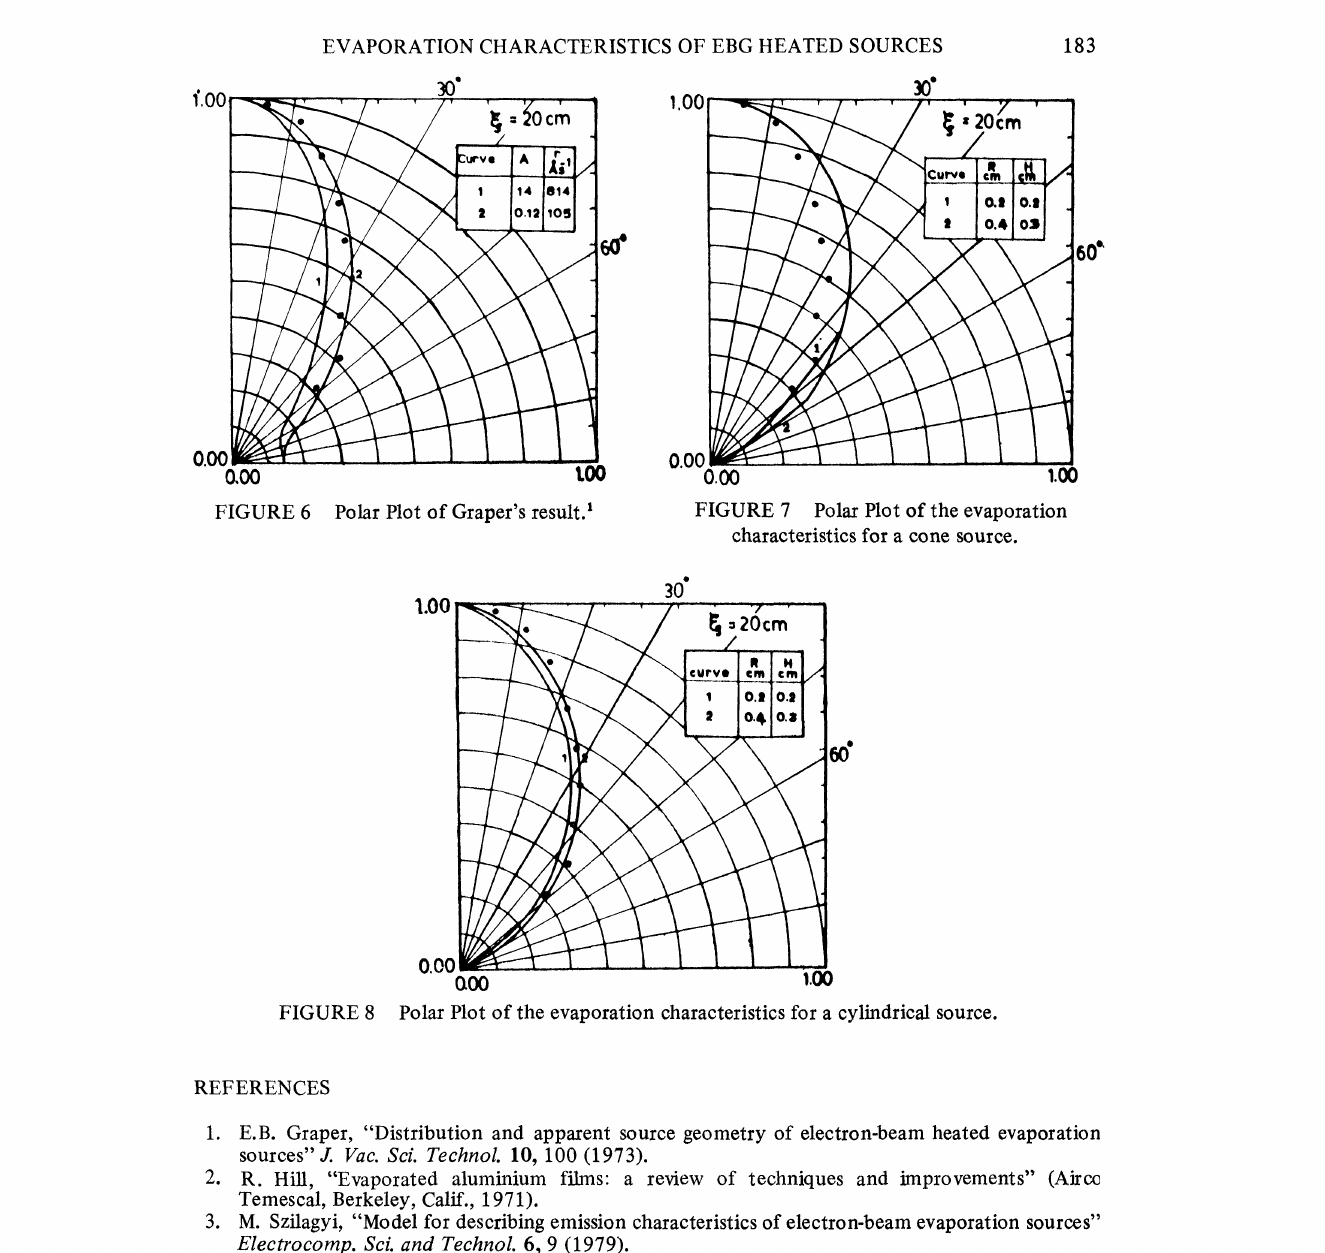
FIGURE 6 Polar Plot of Graper’s result.